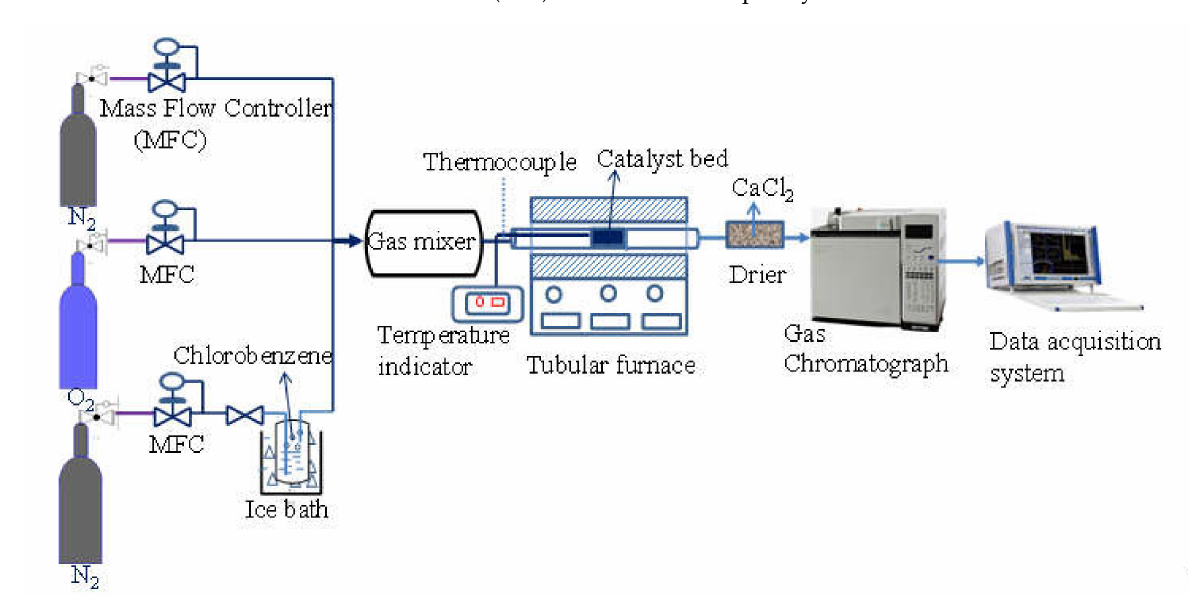
Figure 2. The experimental set-up for the adsorption/catalytic oxidation of